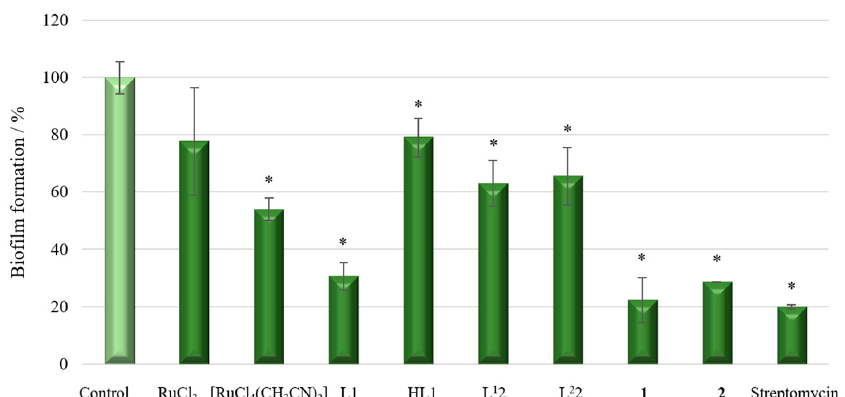
Figure10. P.aeruginosa PAO1biofilmformationinthepresenceofRuCl 3 · xH 2 O,[RuCl 4 (CH 3 CN) 2 ] · 2H 2 O, Figure 10. P. aeruginosa PAO1 biofilm formation in the presence of RuCl 3 ·xH 2 O, free and protonated ligands, and ruthenium complexes (concentrations of compounds—1